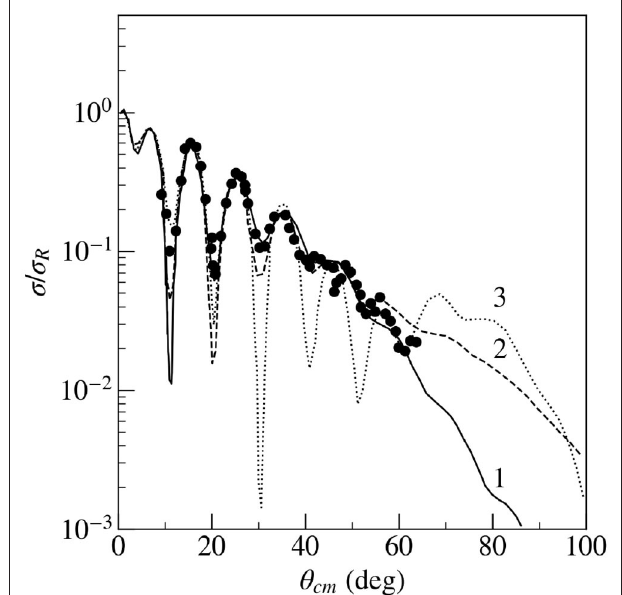
FIGURE 1 | The elastic scattering cross-section of the 10 B ions on the 9 Be target, fitted by optical model calculations with potentials 1—solid line, potential 2—dashed line, and potential 3—dotted line, the depths of the real part of these three optical model potentials were 64.2, 131.2, and 203.2 MeV, respectively, see details in Mukhamedzhanov et al. (1997). Ratio to Rutherford scattering is on the y-axis.